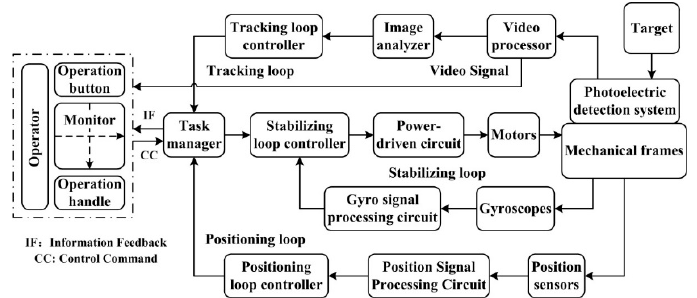
Figure 3. Overall structure of the servo-control functions.